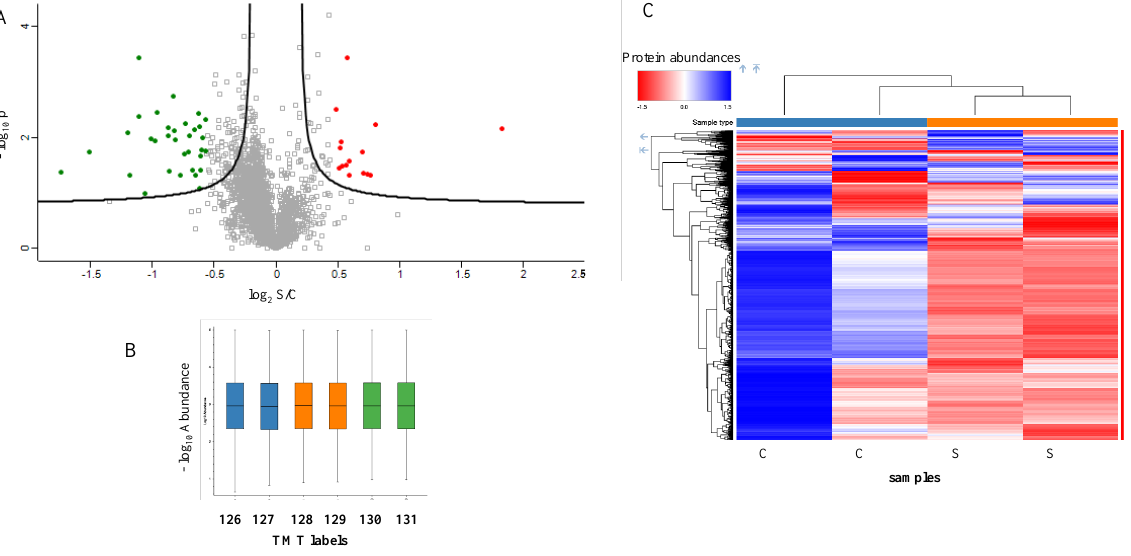
Figure 5. A) Differentially regulated proteins in NAFLD ( S ), compared with control ( C ) resulted Figure 5. ( A ) Differentially regulated proteins in NAFLD (S), compared with control (C) resulted from TMT analyses. Biological duplicates and technical triplicates. B) Correlation analyses of abundances of different labelled samples by TMT. C) Heat map of 2 controls and 2 NAFLD from TMT analyses; biological duplicates and technical triplicates. ( B ) Correlation analyses of the samples. abundances of different samples labelled by TMT. ( C ) Heatmap of 2 controls and 2 NAFLD samples. Overall, the three strategies allowed us to deeply explore the proteome; 4086 proteins were quantified, 884 of which were common to all three quantitative proteomic approaches, whereas 1042 proteins were common among the two labelling strategies, i.e., TMT and SILAC. The label-free technique shared 1650 quantified proteins with the TMT experiment and 1129 with the SILAC experiment (Figure 6).